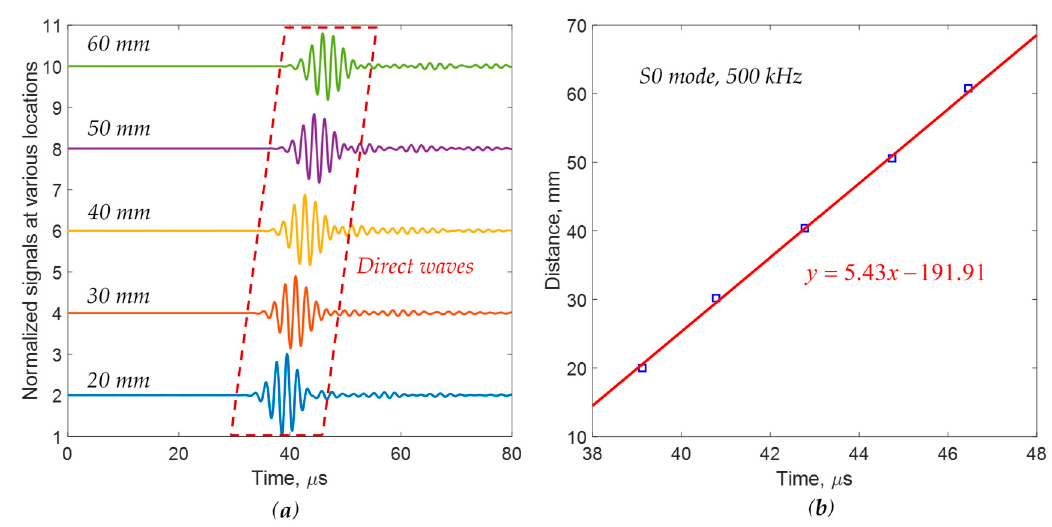
Figure 10. Experimental group–velocity measurements of the S0 mode excitation: ( a ) waveforms at various locations; ( b ) correlation between distance and time of flight for the group velocity